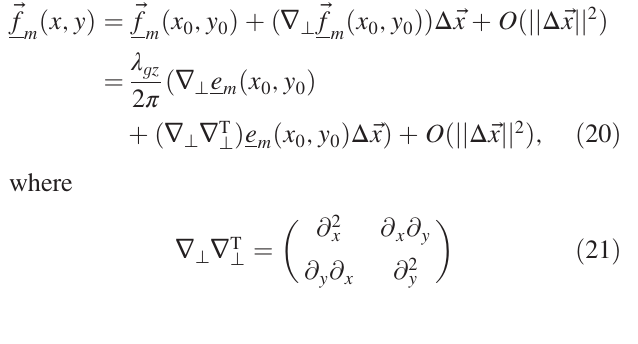
FIG. 7. Contour lines of e 1 ð x; y Þ and kick field analytically and numerically, the bottom plots show the relative